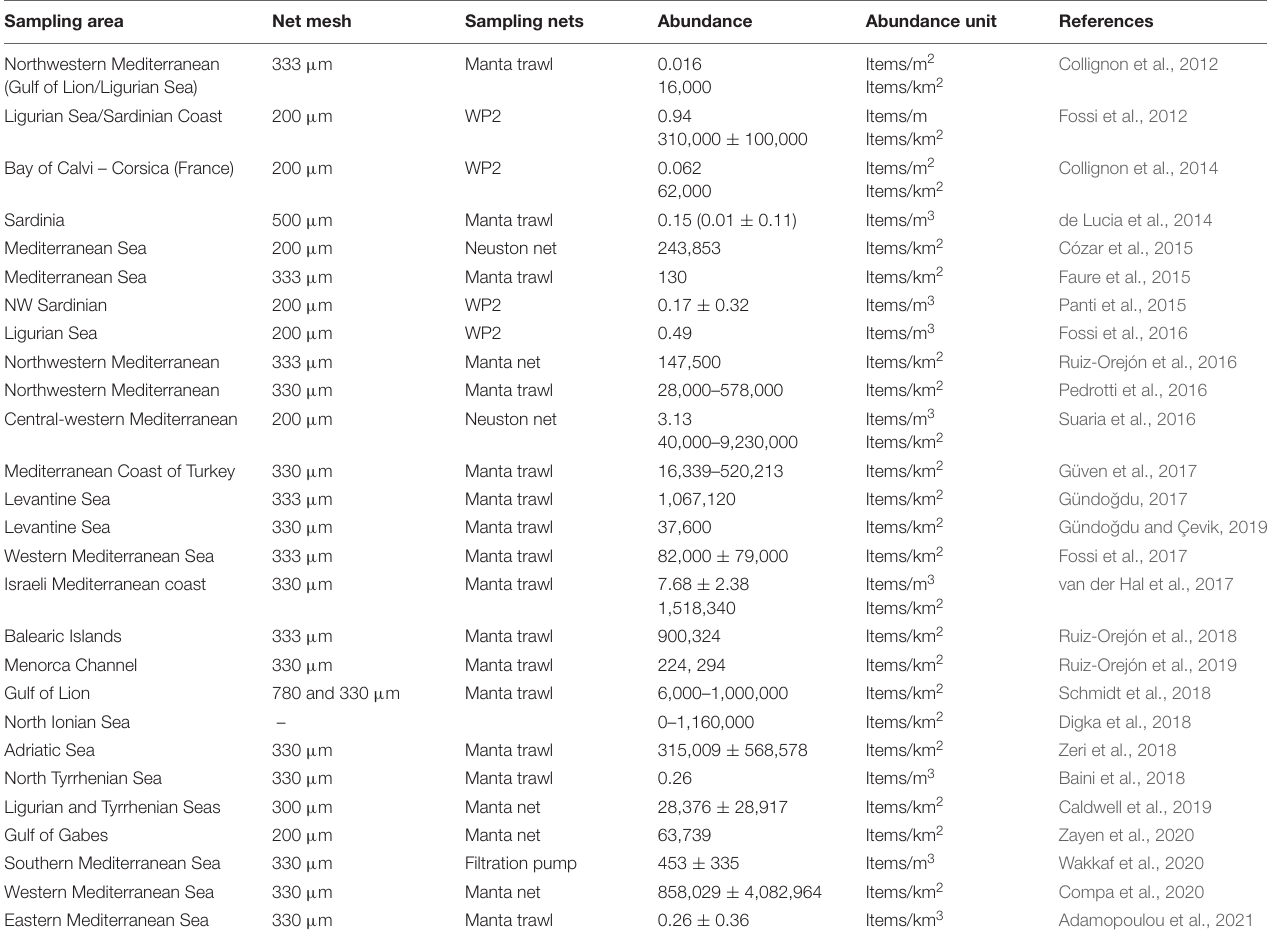
TABLE 1 | Indicative microplastics concentrations in the